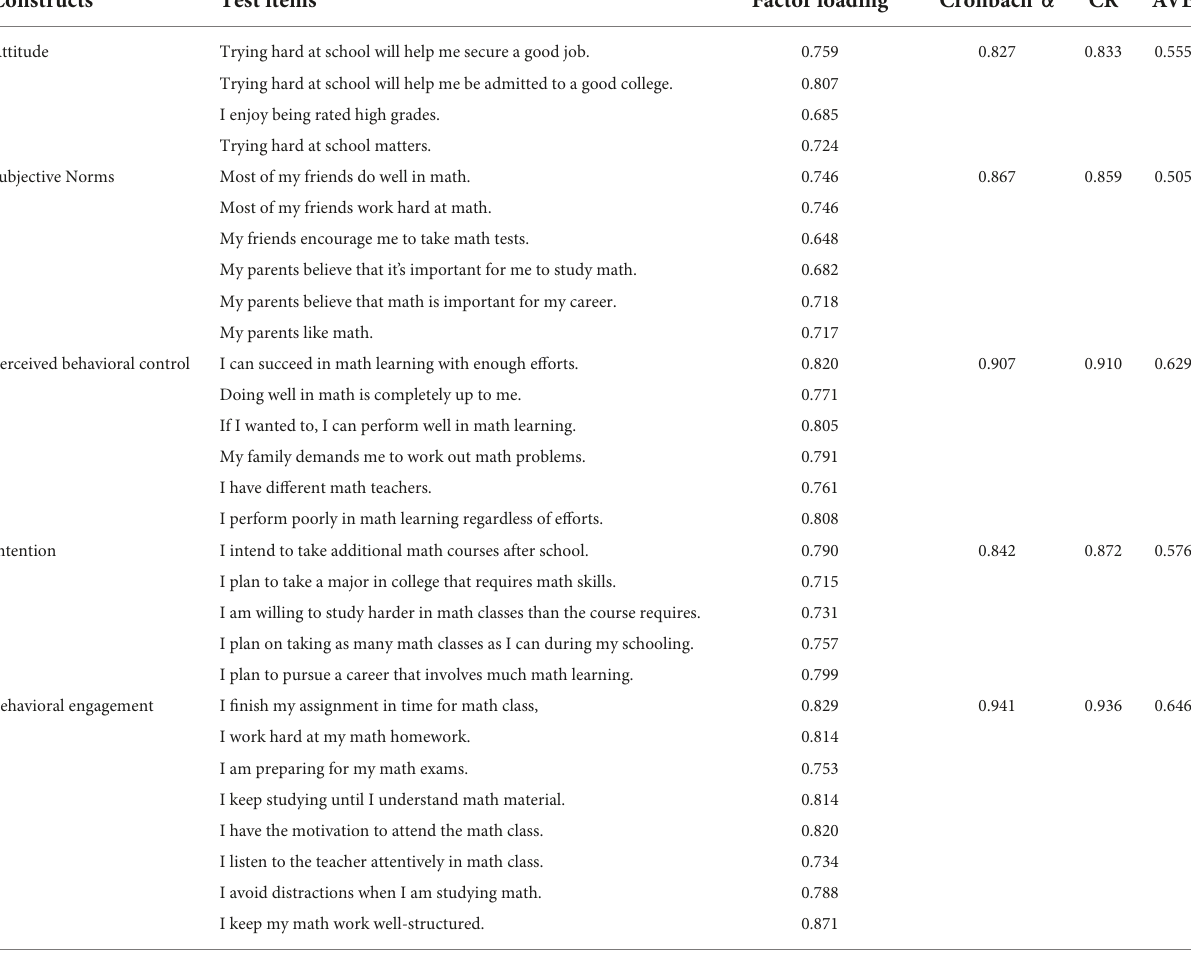
TABLE 1 Reliability and convergent validity.